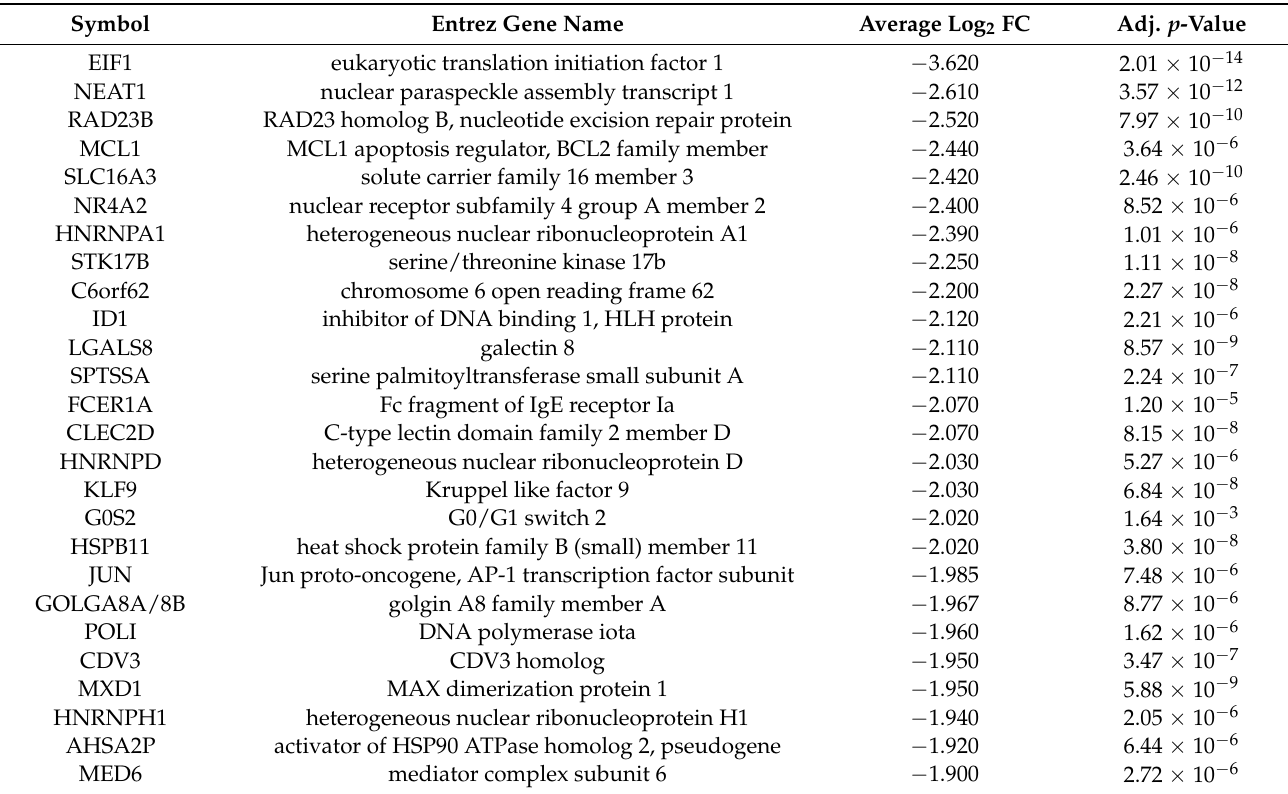
Table 2. Top 25 downregulated genes in MKD patients ( p -value < 0.05, log 2 FC ≤